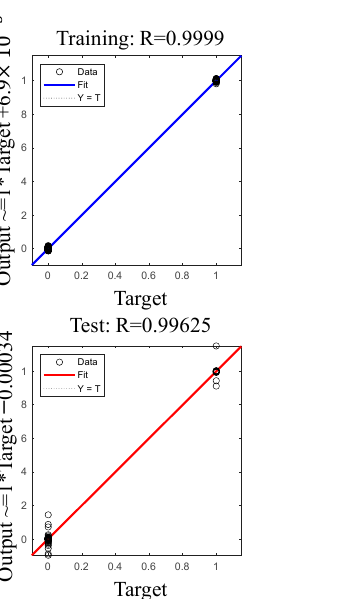
Figure 21. Regression effect of BP neural network model after training. Figures 22 and 23 show the prediction results of input sources at different locations.